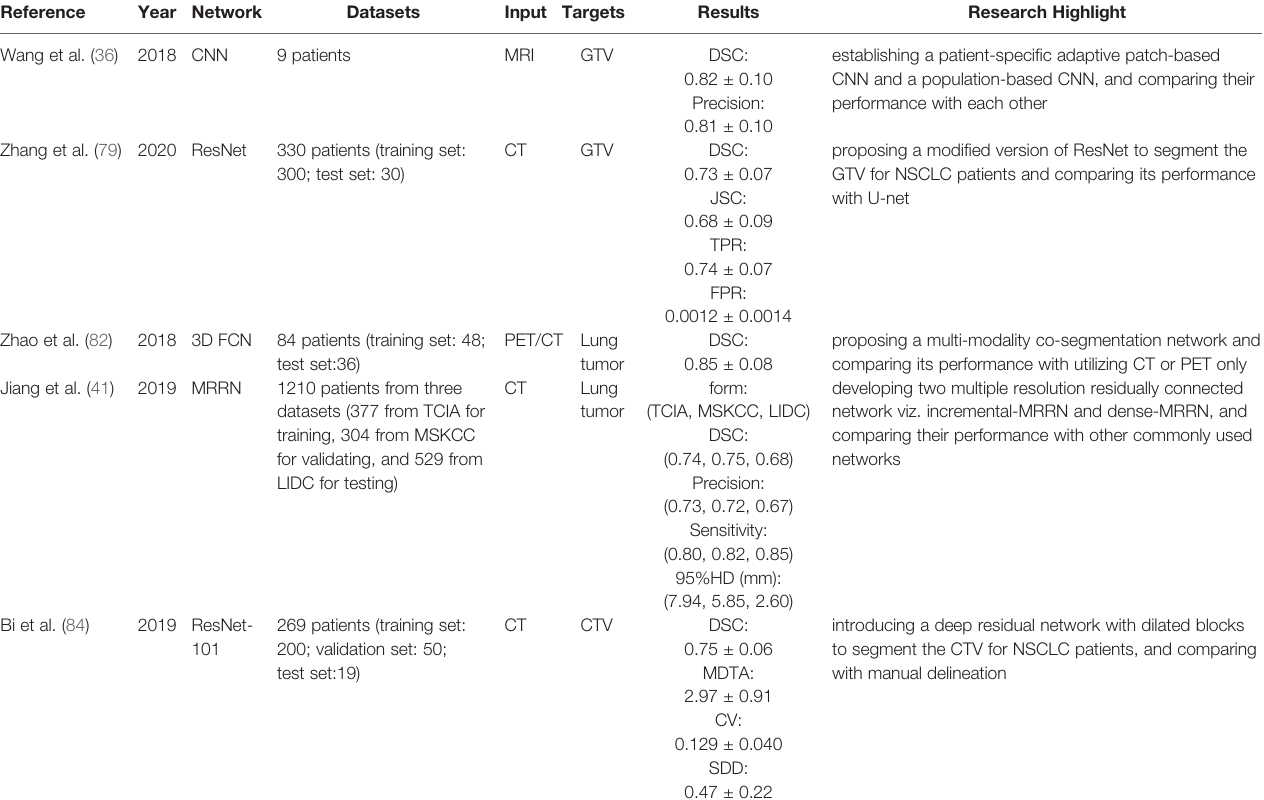
TABLE 8 | Selected works on deep learning-based automated segmentation of lung tumors.